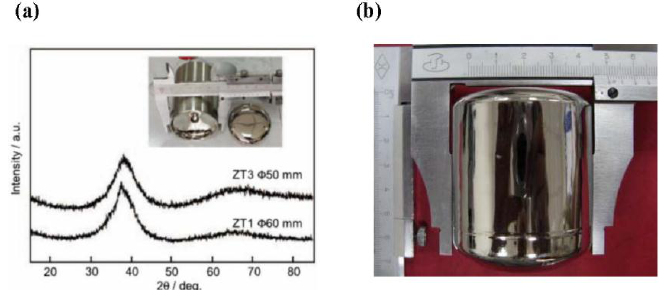
Figure 2. ( a ) X-ray diffraction (XRD) patterns of water-quenched (Ti 36.1 Zr 33.2 Ni 5.8 Be 24.9 ) 91 Cu 9 rods with different diameters (inset is the picture of the 50 mm-diameter rod sample and 100 g pancake). Reproduced with permission from [72]. Copyright 2010, Elsevier. ( b ) The appearance of the 50 mm-diameter Ti 32.8 Zr 30.2 Cu 9 Fe 5.3 Be 22.7 rod sample prepared by copper mold casting. Reproduced with permission from [73]. Copyright 2015, Elsevier.